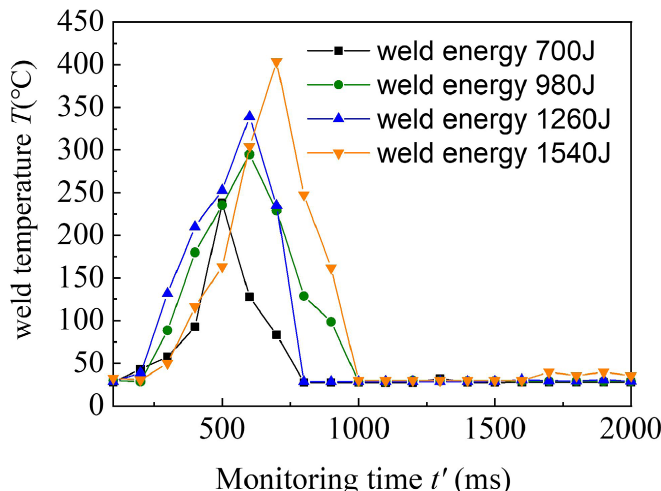
Figure 3. Peak temperature curve of the welding interface with different welding